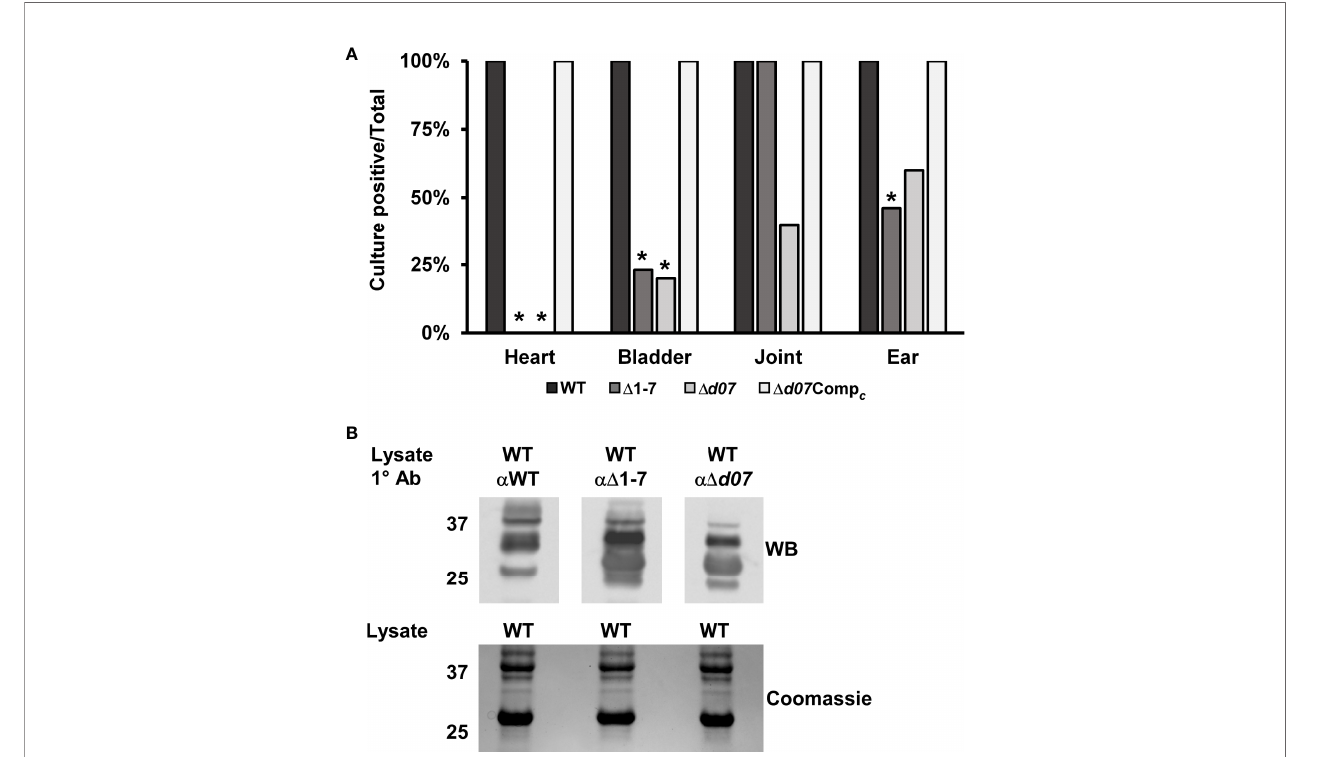
FIGURE 5 | Targeted deletion of bbd07 results in a phenotype comparable to D 1-7. (A) Groups of 10, 5, and 4 mice were infected with 5x10 3 spirochetes of the indicated strains, respectively. Indicated tissues were harvested at day 28 post-infection and cultured in BSK for detection of spirochete growth as described above. Data bars indicate the percentage of mice in each group that were culture positive for spirochete growth in the indicated tissues. D 1-7 data was transposed from (Casselli et al., 2019). Asterisks indicate statistically signi fi cant difference compared with wild type as determined by Fisher ’ s exact test ( P < 0.05). (B) Anti-sera were extracted from mice (n = 5) infected with the indicated strains for 28 days. The sera were used as the primary antibody in a western blot probing protein lysate of in vitro cultivated wild type spirochetes. A gel loaded identically to that used for the Western blot was Coomassie stained to serve as a protein loading control and is shown below the